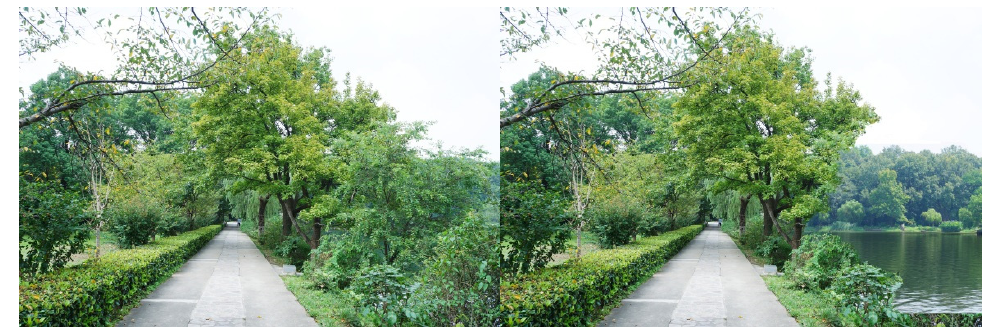
Figure 8. Example: Visual accessibility (“screening” height shrubs in front were partly removed, to reveal water view beyond).